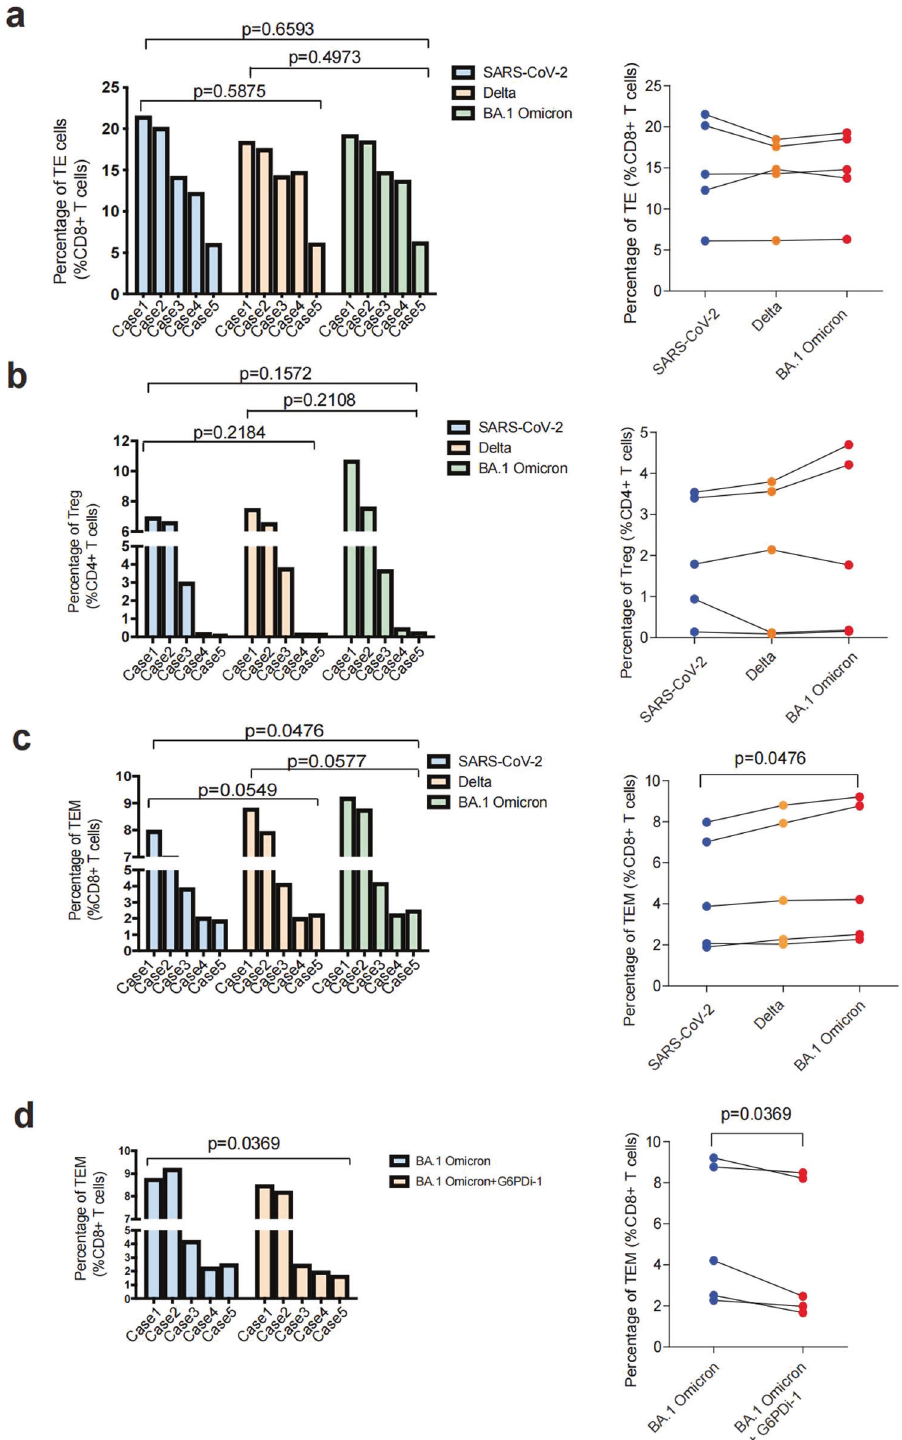
Fig. 4 Difference in T cell differentiation after stimulated by SARS-CoV-2 variants. a – c Fraction of effector T cells (TE) ( a ), Treg cells ( b ), and effector memory T cells (TEM) ( c ) among SARS-CoV-2, Delta or Omicron-speci fi c CD8 + T cells, respectively. d Fraction of TEMs in Omicron- speci fi c CD8 + T cells before and after G6PDi-1 treatment. Data are represented as mean ± SEM, p -value was determined by two-way ANOVA (Supplementary Fig. 10). These results indicated that T cells promoted the survival and production of TEMs. The inhibitor of activated by SARS-CoV-2, Delta and BA.1 Omicron are of various the PPP, G6PDi-1, could restore the fraction of TEM (Fig. 4d). We activation states, in which BA.1 Omicron variant preferentially analyzed the extracellular acidi fi cation rate (ECAR) of antigen promoted formation and maintenance of CD8 + TEMs by increas- speci fi c T cells triggered by antigens from SARS-CoV-2 variants. ing PPP. Glycolic pathway was activated in all groups, as shown by ECAR Signal Transduction and Targeted Therapy (2023)